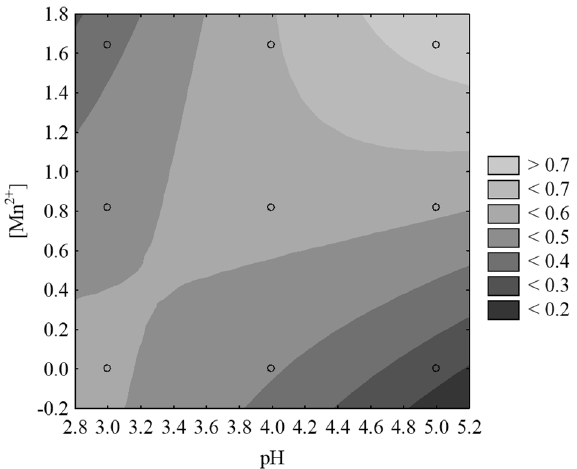
Figure 2. Graph of contours of the TMP relative concentration (C / C 0 ) as resulting from variable interaction [Mn 2 + ] and pH ([H 2 O 2 ] = 4.41 mmol L − 1 , [Fe 2 + ] = 0.81 mmol L − 1 , t = 60 min).